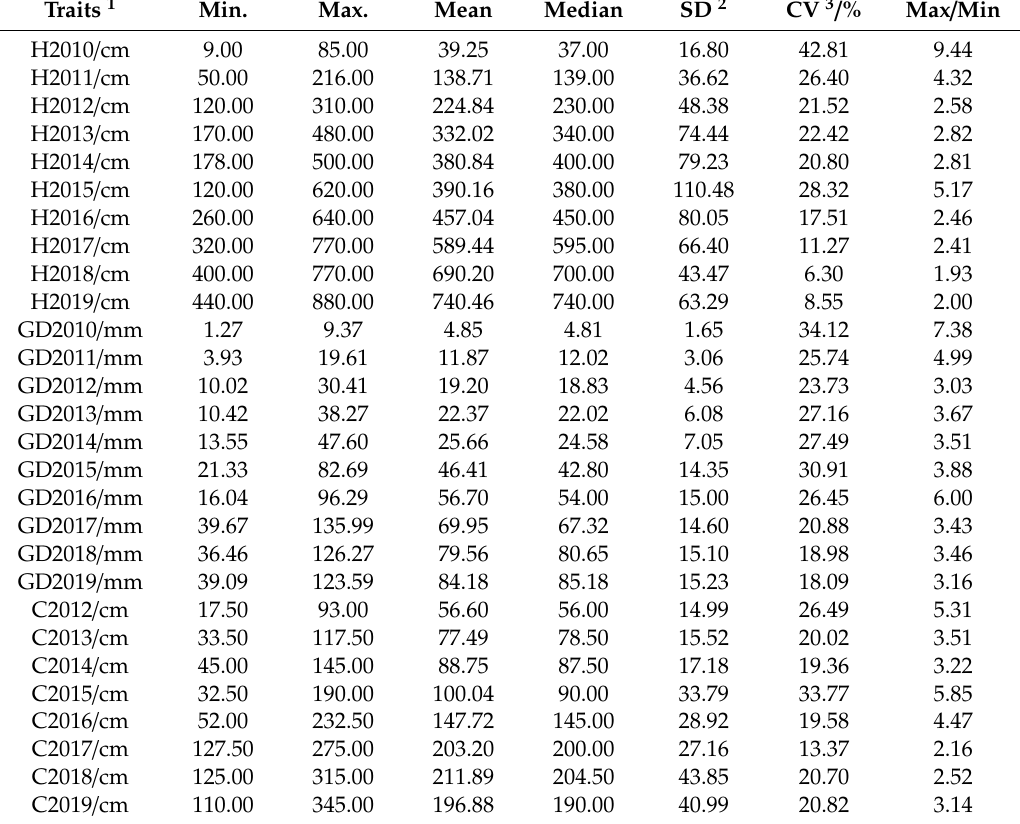
Table 2. Distribution of measured traits of Eucommia ulmoides .